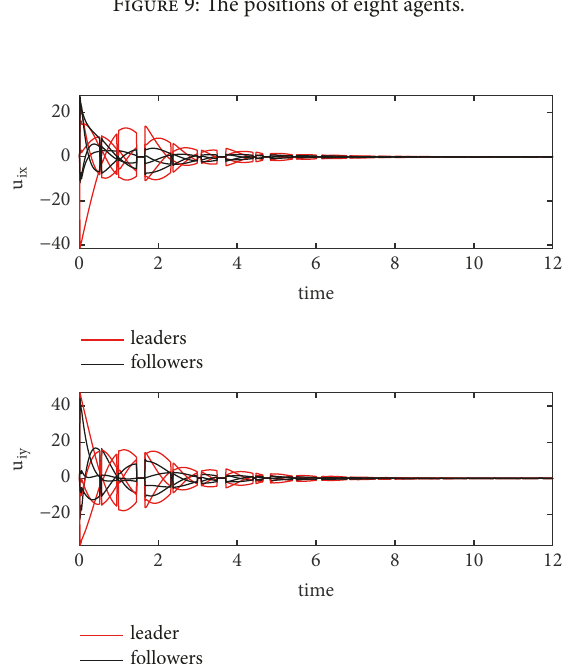
Figure 9: The positions of eight agents.